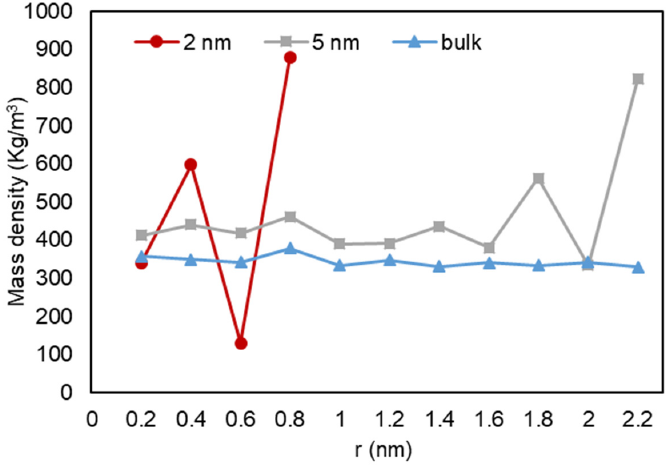
Figure 20. Mass density variation vs. radial position for C3.